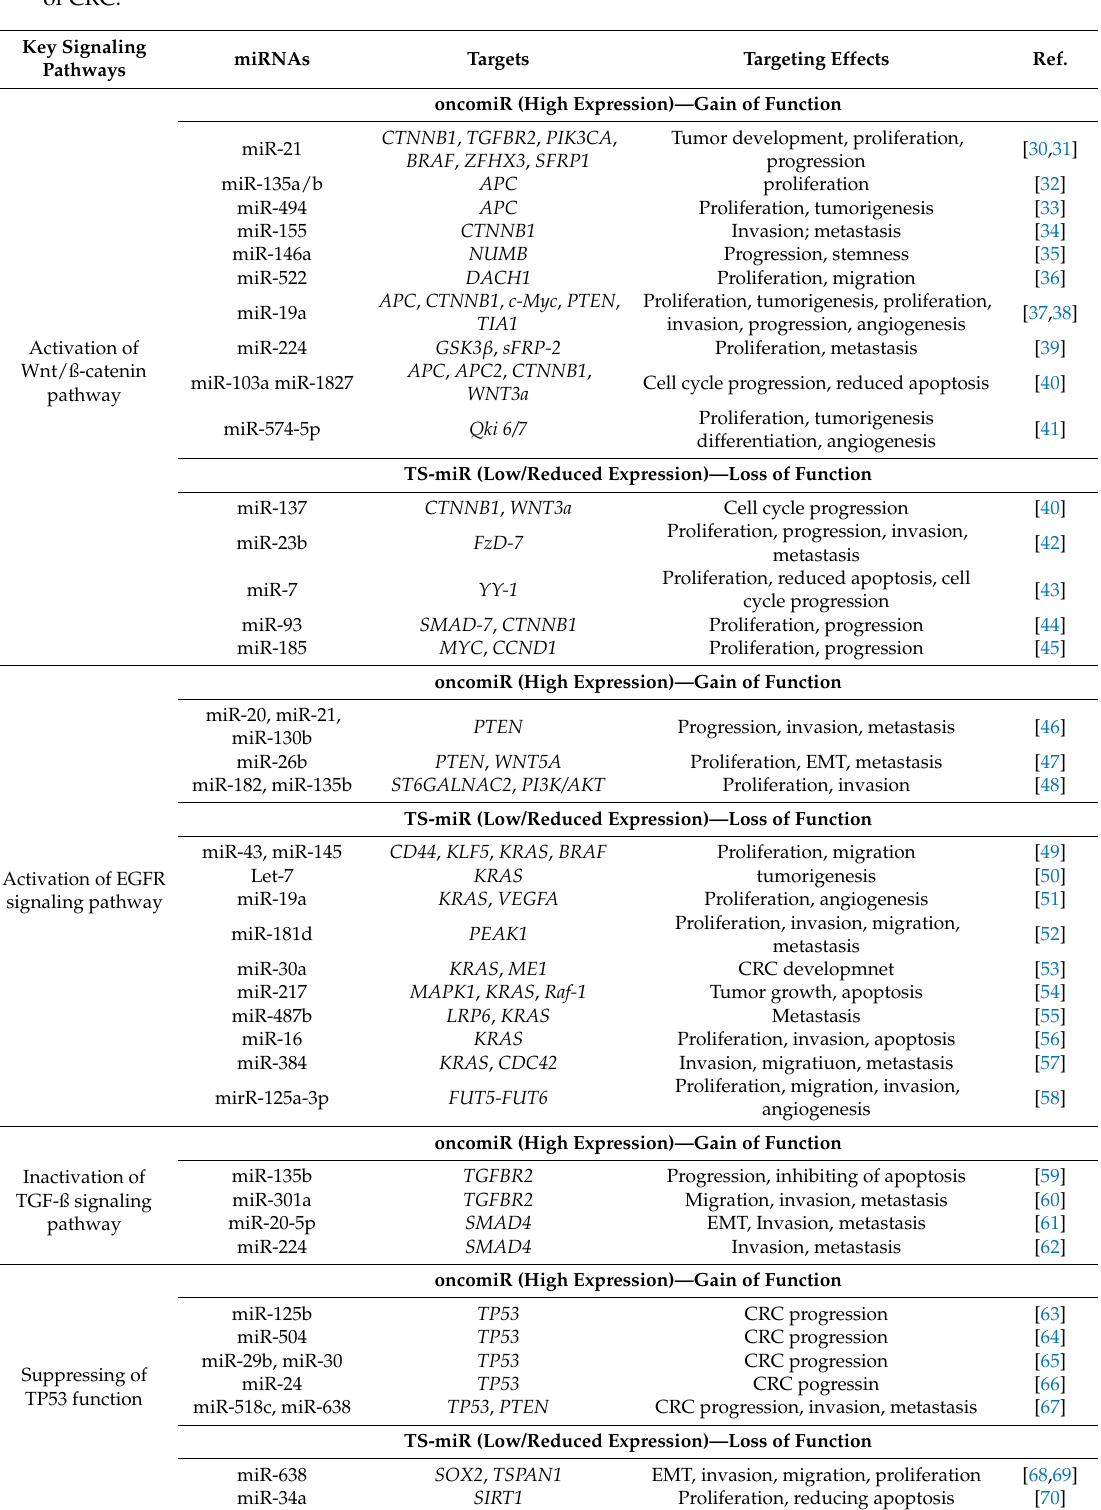
Table 1. MiRNAs and their mRNA targets associated with the development, progression and metastasis of CRC. Key Signaling